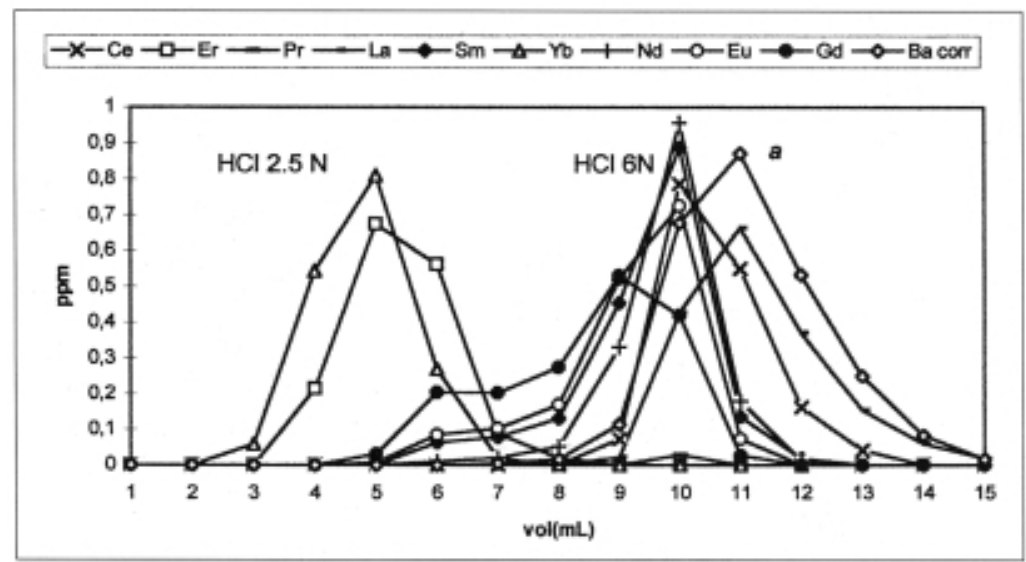
Fig. 3a – Columns calibration for minerals analysis: REEs elution, where was necessary the concentra- tion correction from blank value obtained in ICP/AES for Ba